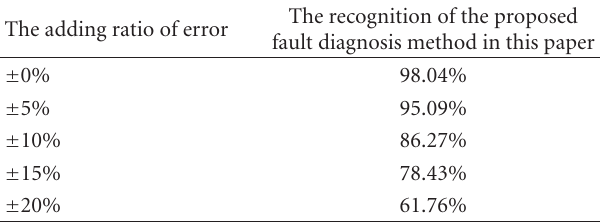
Table 6: The test result of the fault